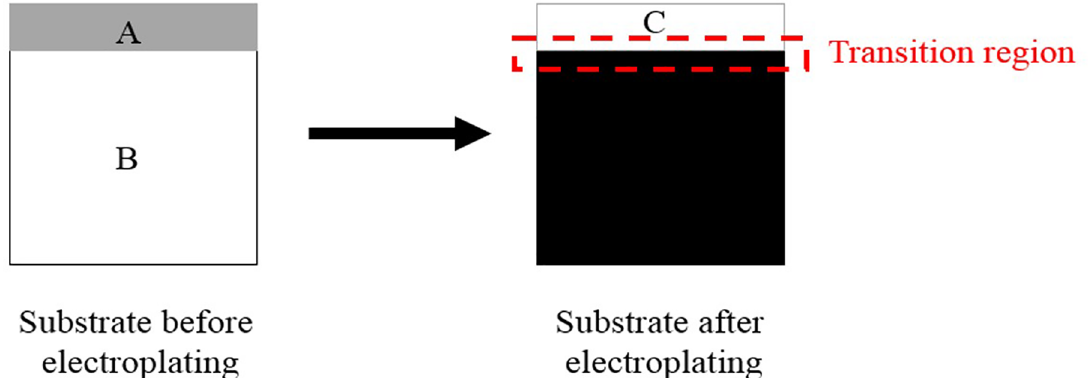
Figure 1. (a) region of the substrate that has been prevented from being deposited, (b) region of the substrate where the deposition will be made, (c) region of the substrate that was not covered during electrodeposition.